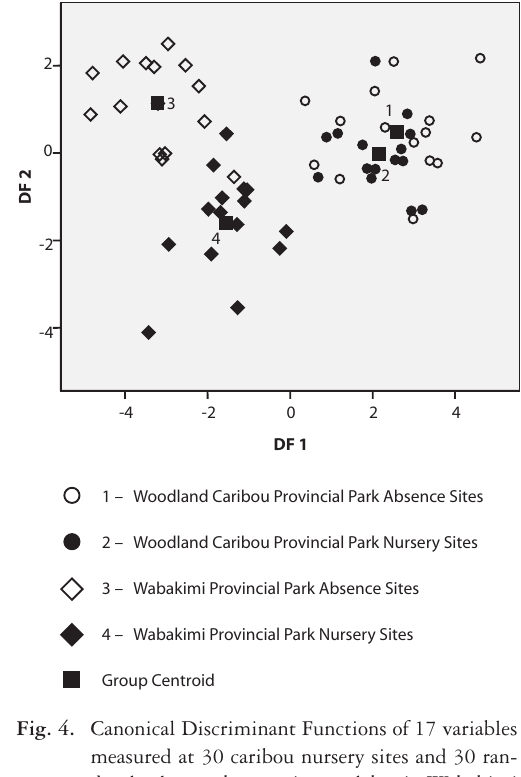
Fig. 4. Canonical Discriminant Functions of 17 variables measured at 30 caribou nursery sites and 30 ran- domly chosen absence sites on lakes in Wabakimi and Woodland Caribou Provincial Parks, north- ern Ontario. The x -axis (DF 1) indicates differ- ences between the parks and the y-axis (DF 2) indicates differences between caribou nursery and unused absence